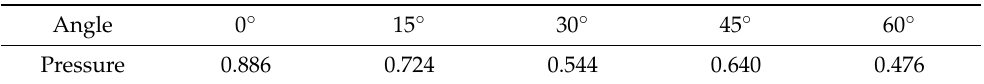
Table 3. Dimensionless measured peak pressure with various angles of incidence (see Figure 11) at 50 charge radii above steel